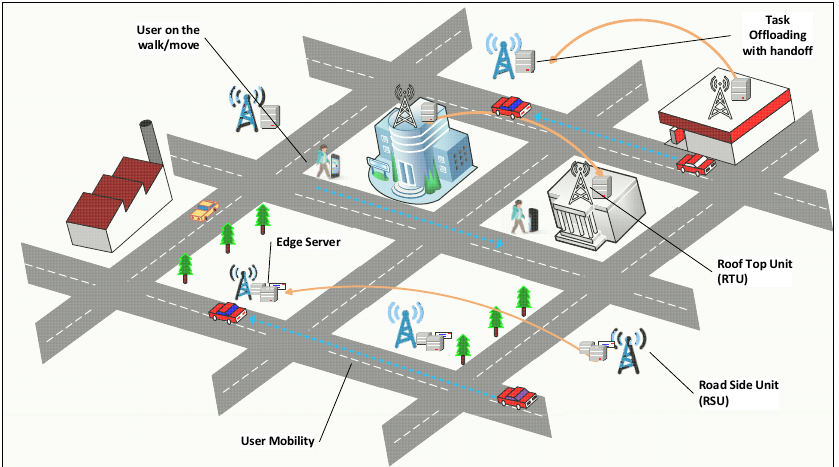
Figure 1. Scenarios of task offloading with user mobility and handovers. Optimal server selection enhances the success of computation offloading in MEC.